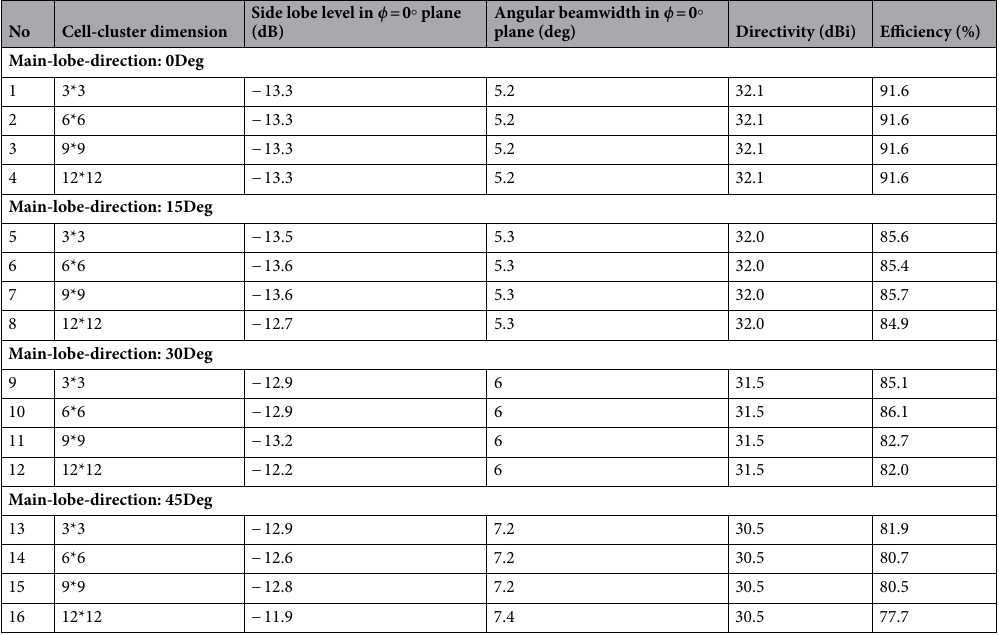
Side lobe level in ϕ = 0 ◦ plane (dB)